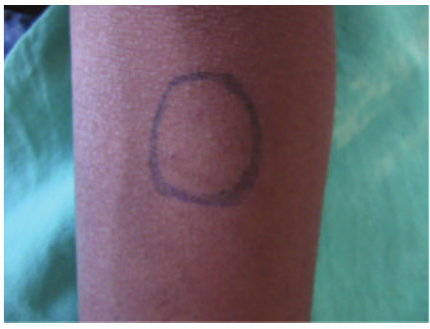
Figure 7: Negative pathergy